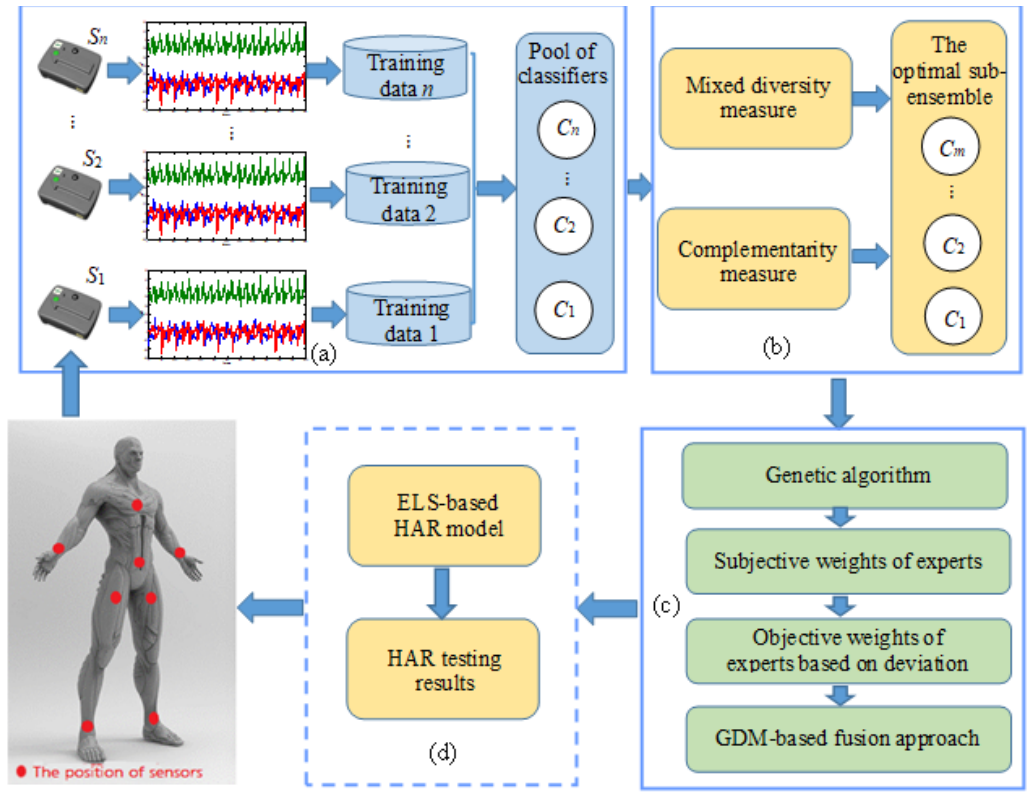
Figure 1. The flowchart of the proposed ELS-based HAR approach. Firstly, in ( a ), diverse base classifiers are trained using training data corresponding to each body position. In ( b ), the optimal sub-ensemble of ELS is selected by taking into account two diversity measures. In ( c ), the GDM-based fusion method is utilized to combine the base classifiers. Finally, in ( d ), the final prediction is produced by the proposed ELS-based HAR model.